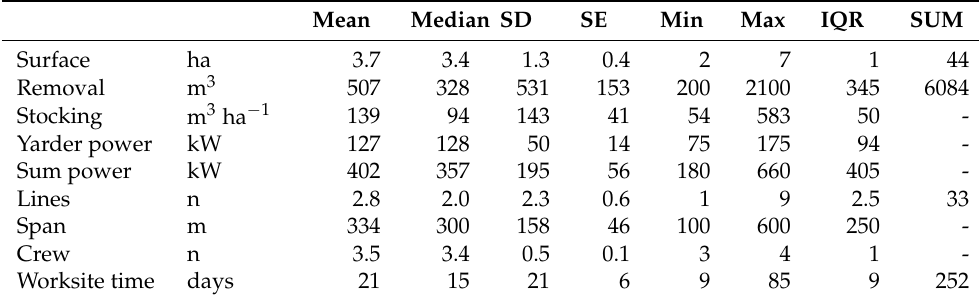
Table 2. Study sites: descriptive